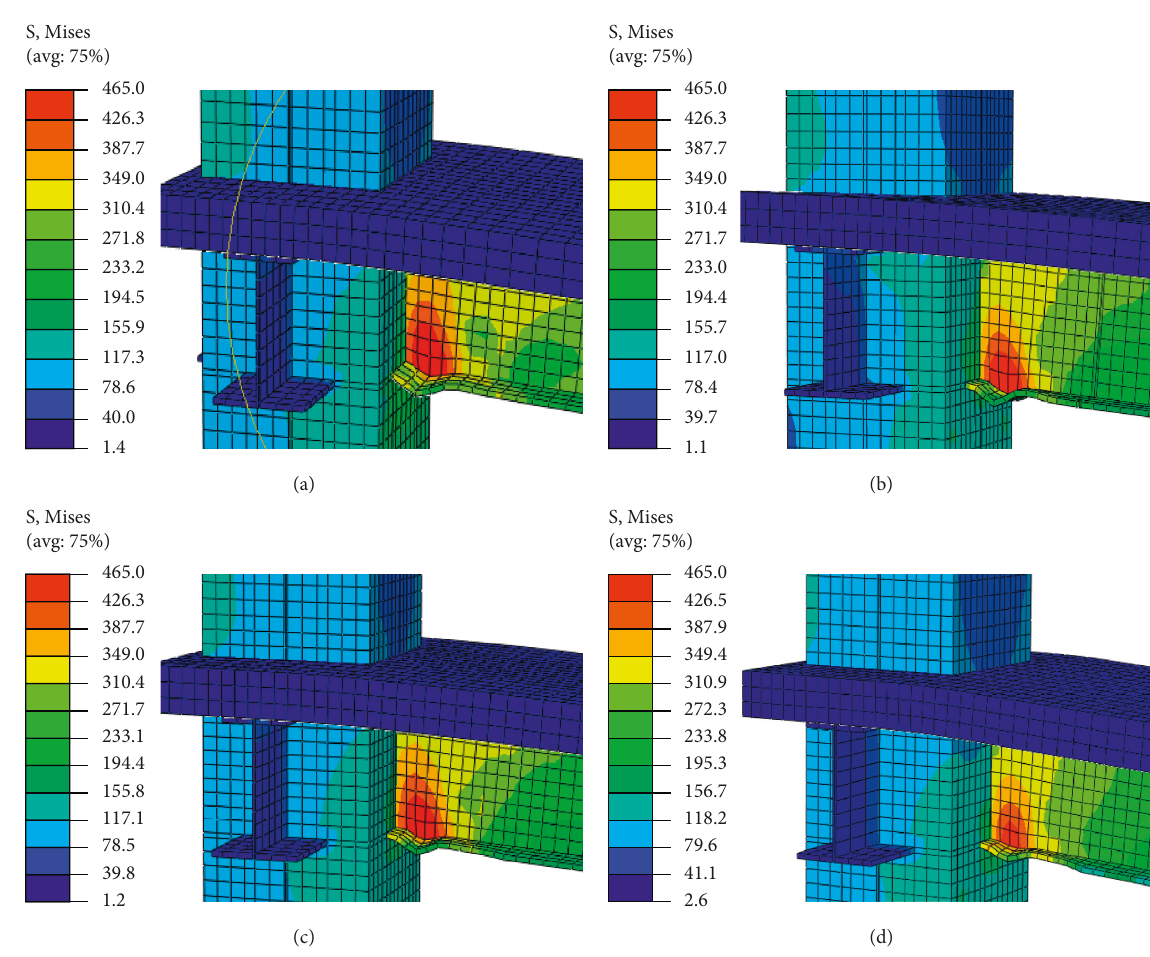
Figure 9: Failure mode by FE analysis: (a) CFCJ1; (b) CFCJ2; (c) CFCJ3; (d)